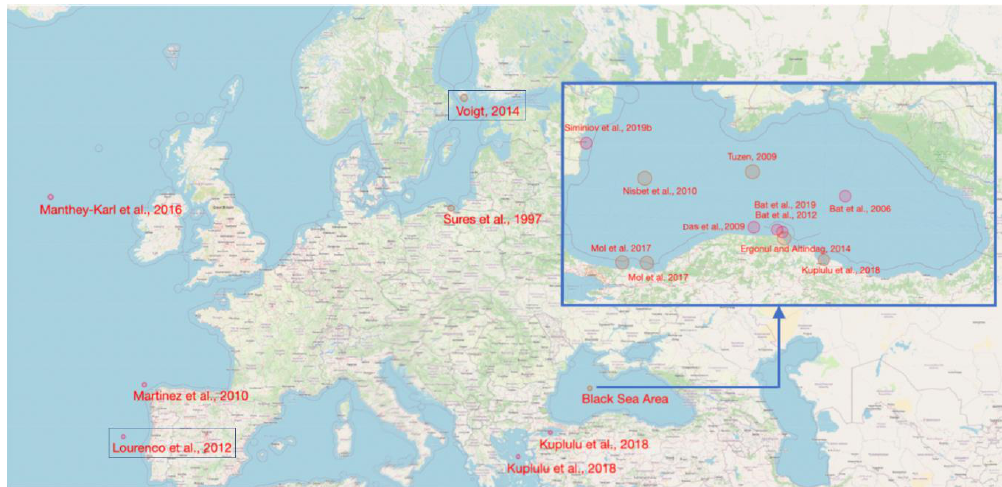
Figure 2. The sampling area of the scientific studies used as dataset for developing the analytical framework (the literature sources which present only data recorded for aquaculture turbot specimens are bordered, while sources that present data for wild turbot specimens are not bordered).